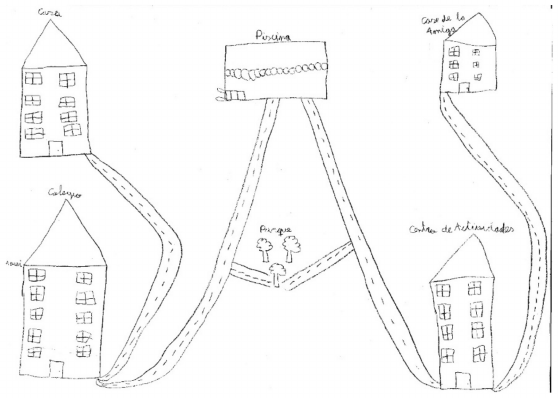
Figure 3. IP499. Girl, urban